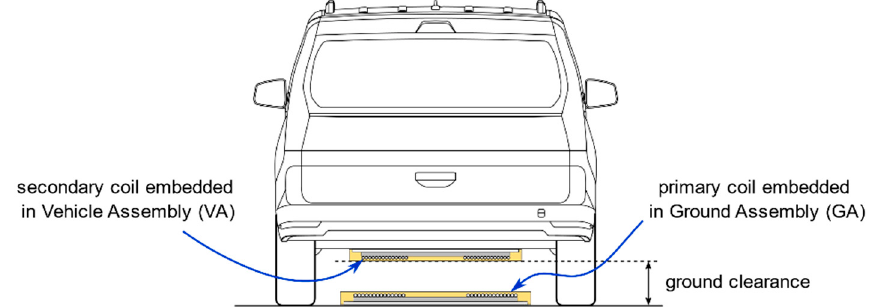
Figure 15. Typical Society of Automotive Engineers (SAE)-compatible IWPT configuration for vehicular battery recharging, with the magnetic coupling positioned underneath the vehicle.